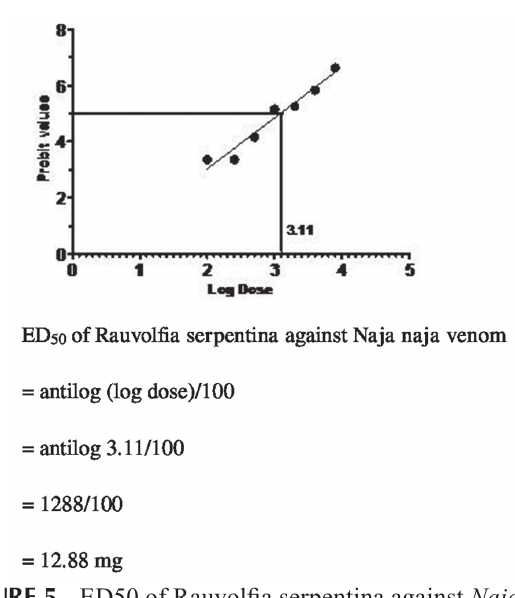
FIGURE 5 - ED50 of Rauvolfia serpentina against Naja naja venon.